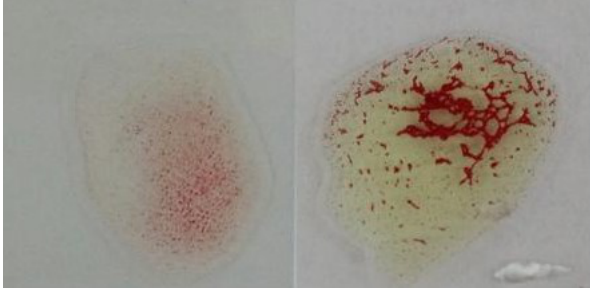
( a ) Matching with the old reference image.